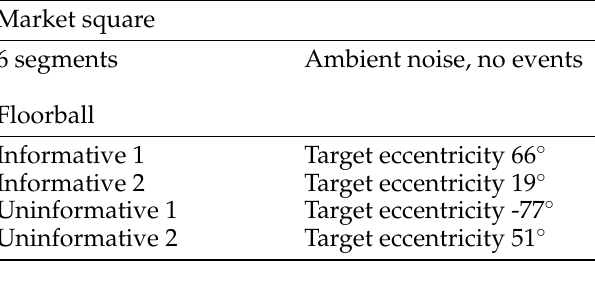
Stimulus scenes and segments.